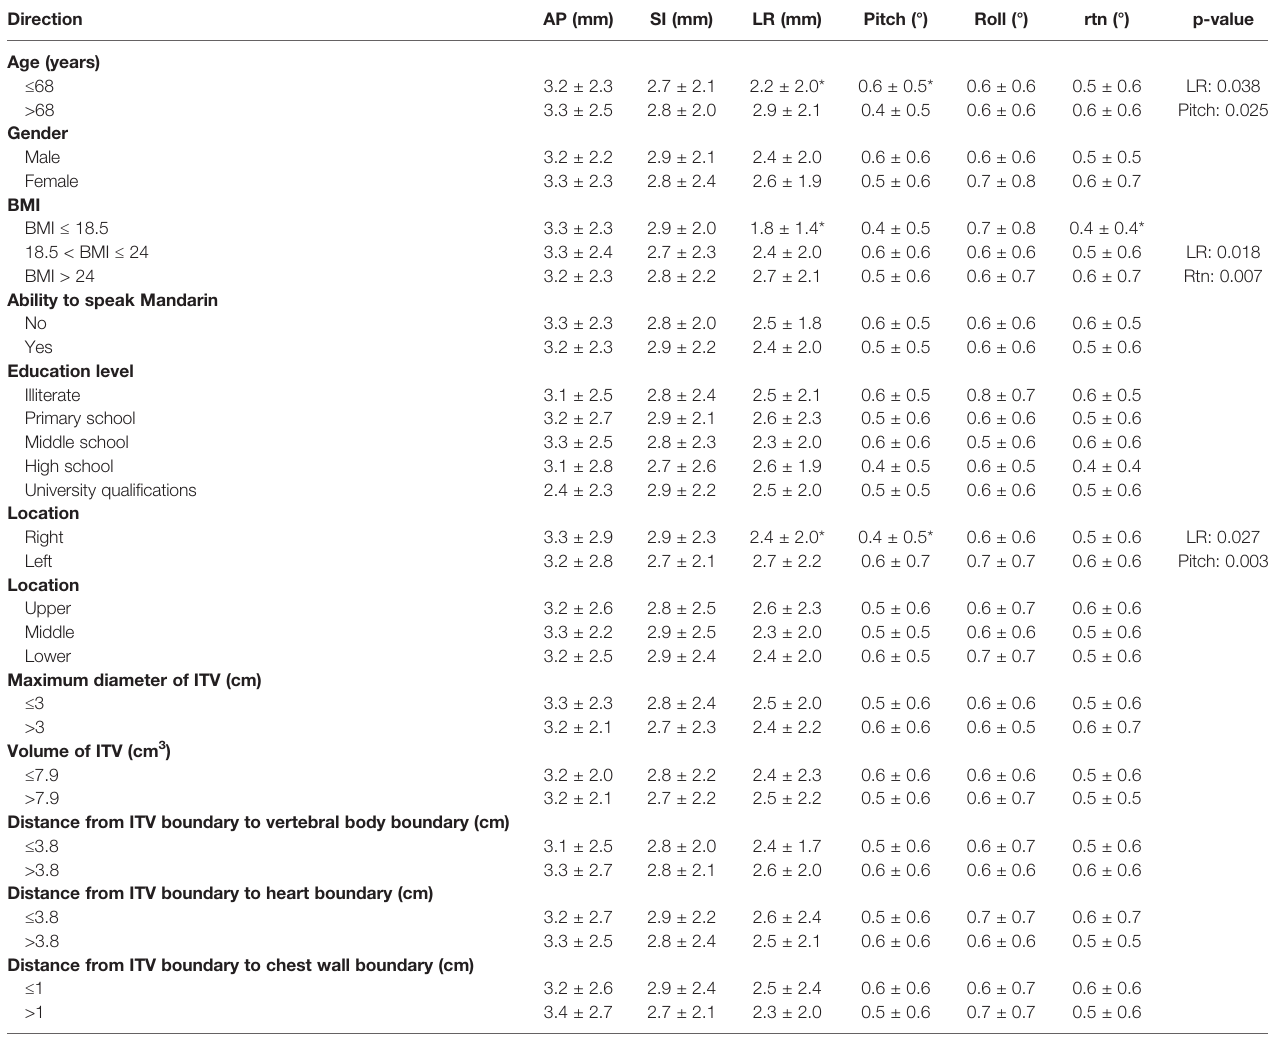
TABLE 4 | Group comparison for clinical and tumor characteristics.